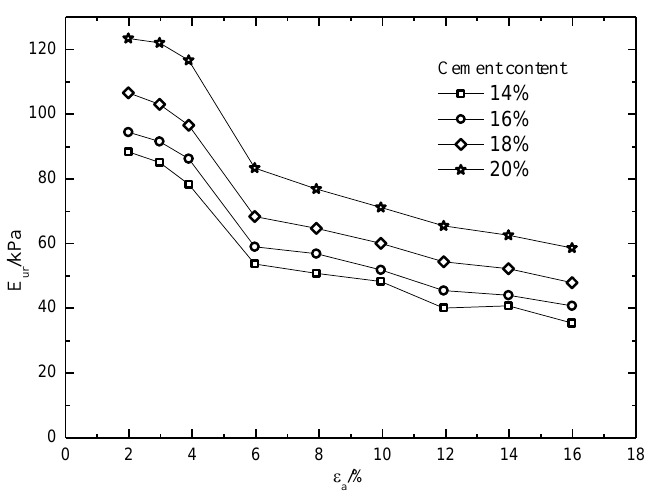
Figure 7. Resilient modulus versus axial total strain under different cement contents.